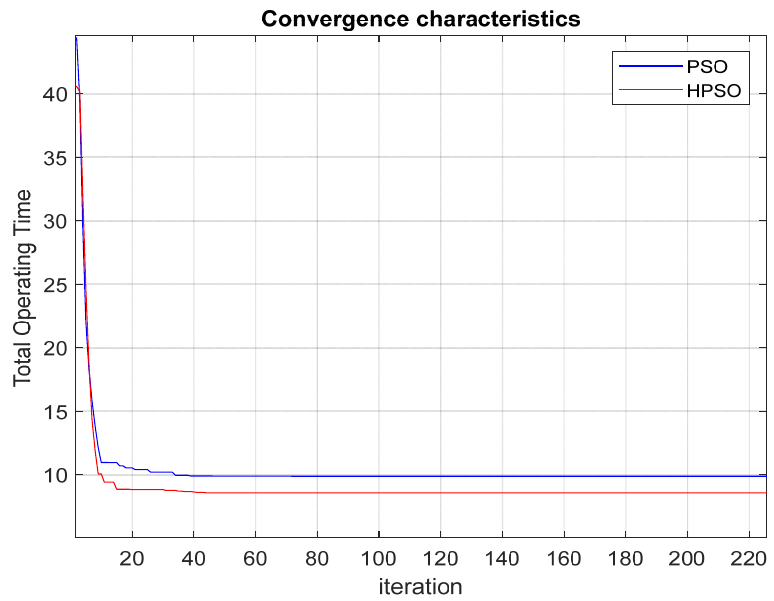
Figure 4. PSO and HPSO convergence characteristics of IEEE 9-Bus system.